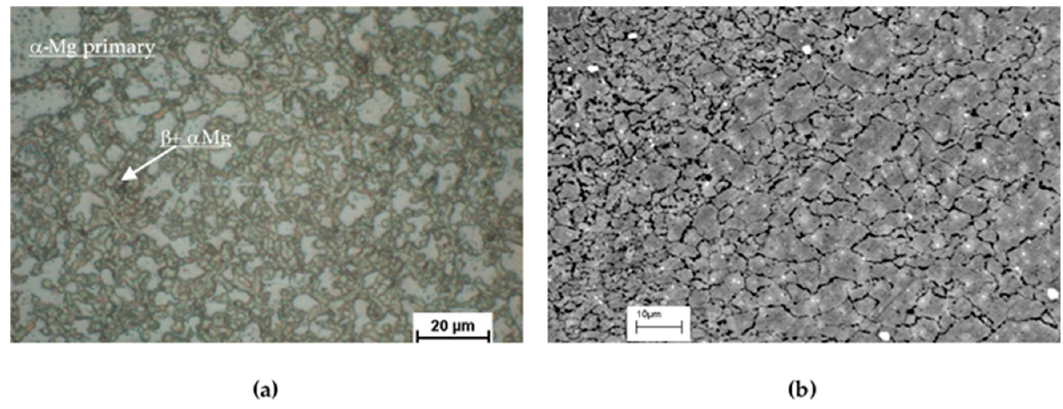
Figure 2. Microstructure of AZ91 magnesium alloy: ( a ) in the HPDC state (or base material, BM), showing the α -Mg primary and the morphology of the eutectic with the α -Mg secondary and β -phase; ( b ) after FSP at 2500 rpm and 30 mm/min, illustrating the refinement .